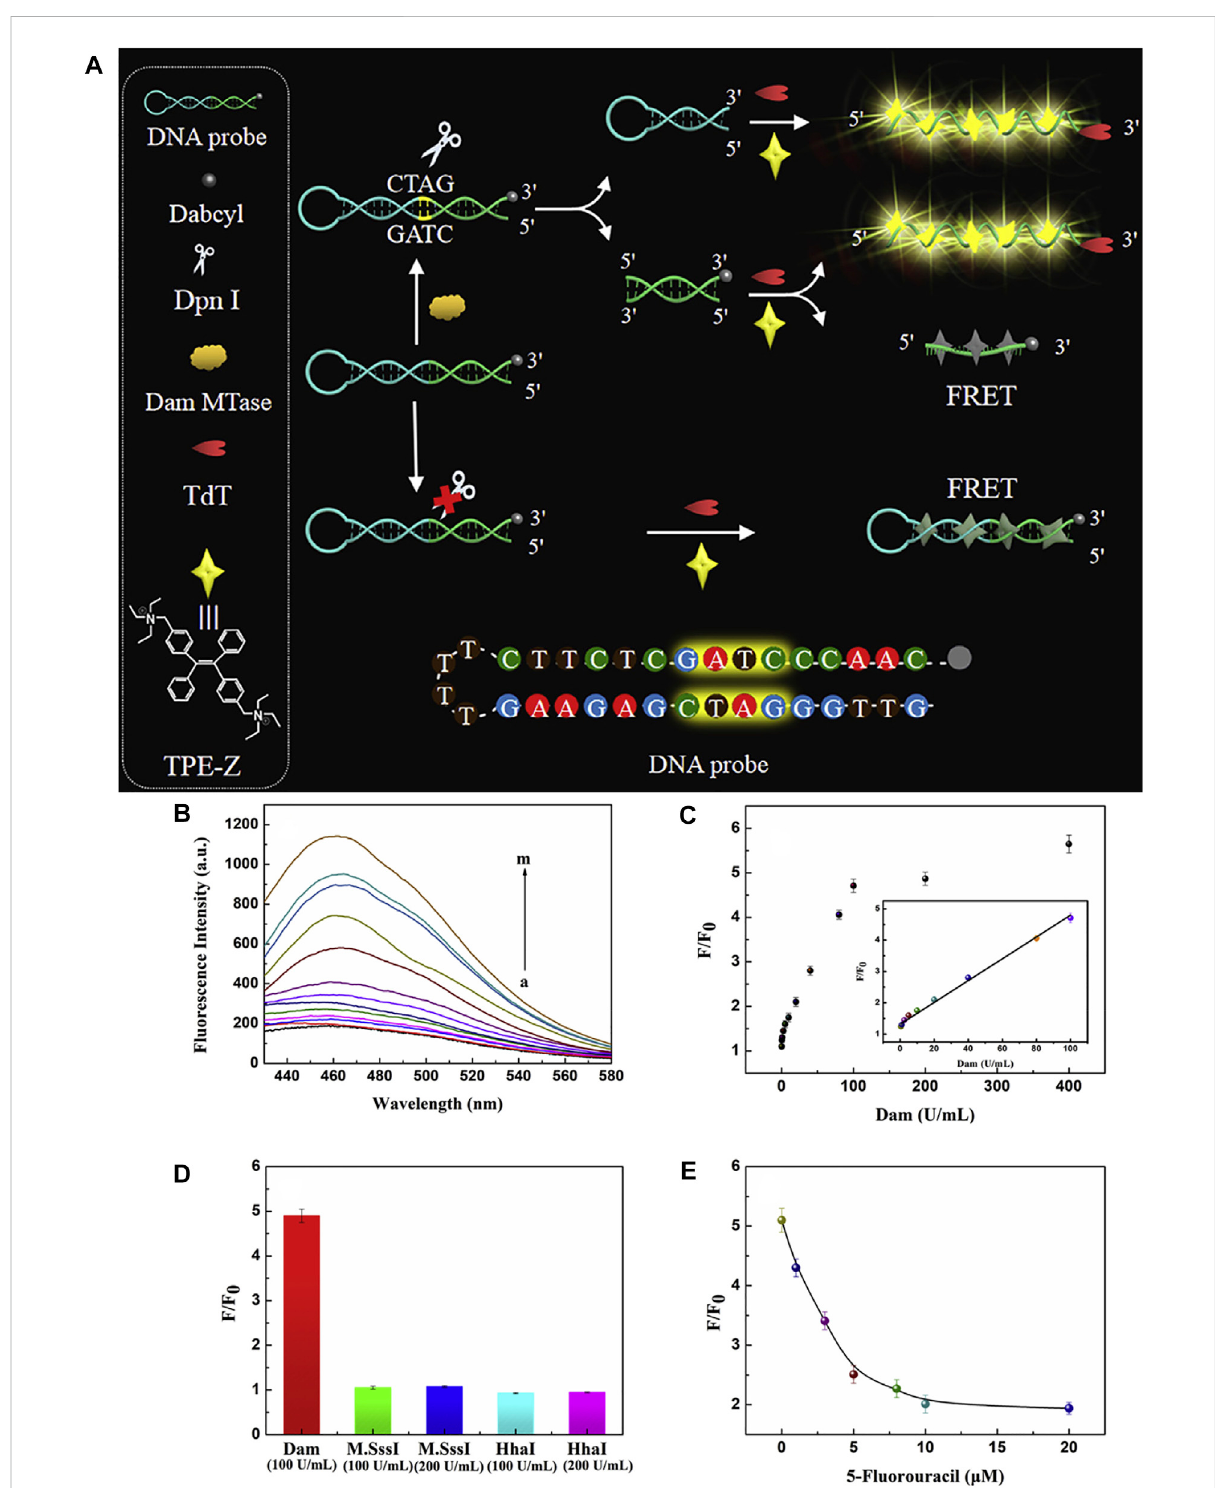
FIGURE 12 (A) Illustration of Dam MTase activity assay based on aggregation-induced emission and template-free DNA polymerization. (B) Fluorescence spectra of TPE-Z in response to Dam MTase in different concentrations (0, 0.1, 0.5, 1, 2.5, 5, 10, 20, 40, 80, 100, 200, 400 U/mL). (C) Corresponding fl uorescence ratio at 462 nm. The inset represents the linear relationship between the signal and Dam MTase concentrations from 0.5 U/mL to 100 U/mL. (D) Selectivitystudy. (E) InhibitionassayforDamMTasewithdifferentconcentrationsof5- fl uorouracil.Theerrorbarswerebasedon three repetitive experiments performed (Niu et al.,